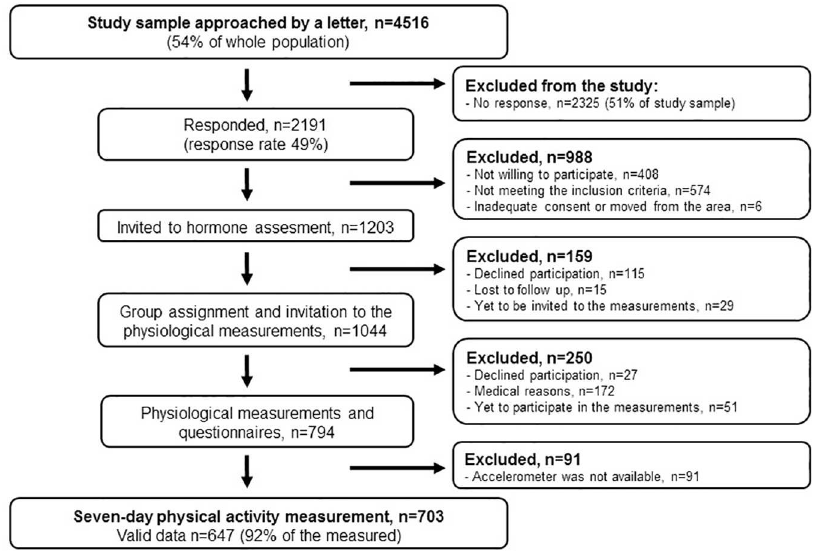
Fig 1. Flow diagram of the recruitment of study